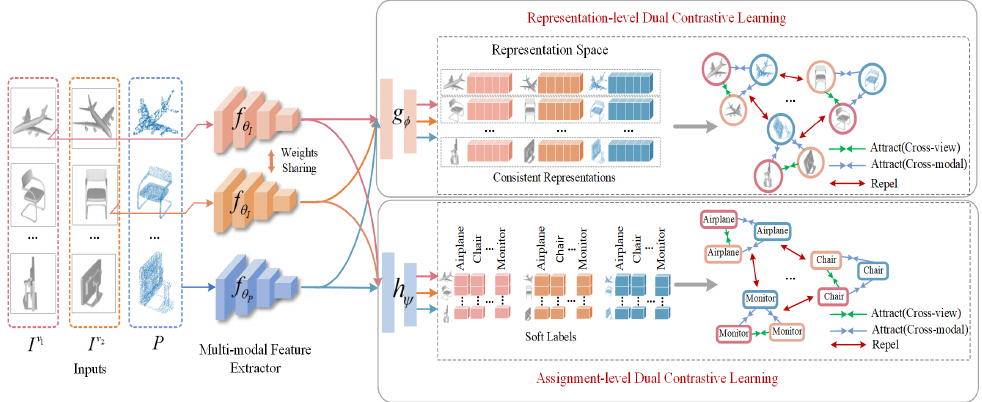
Figure 1. The architecture of the proposed DCL-Net for multi-modal 3D shape